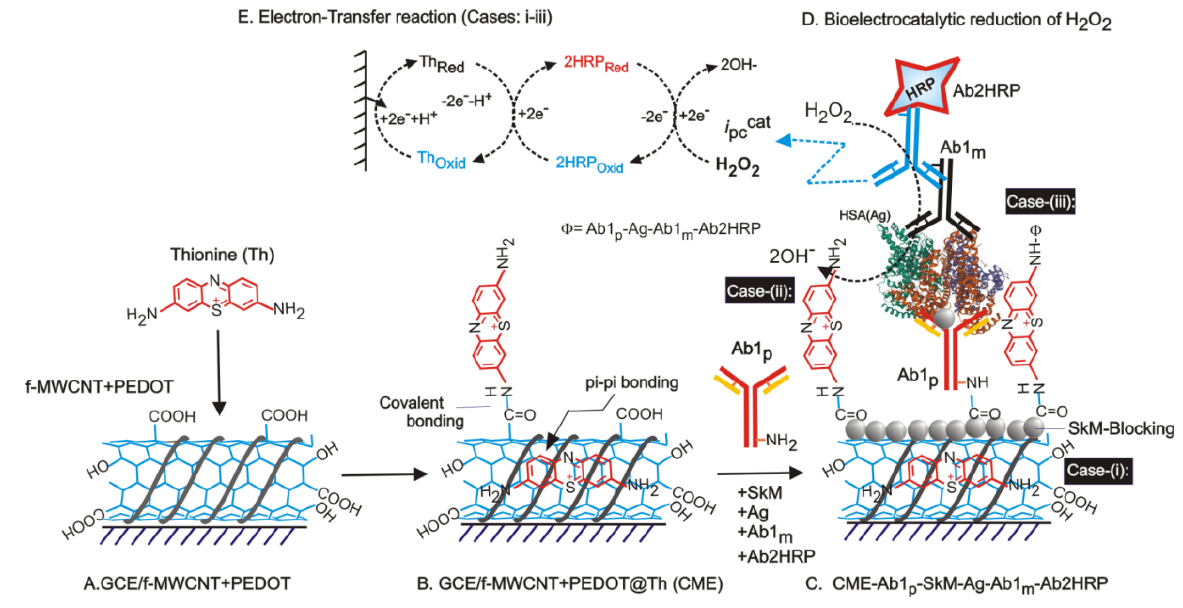
Figure 3. Diagrammatic illustration for preparation of electrochemical biosensor for human serum albumin (HSA) present in urine samples using a sandwich ELISA involving CME-Ab1 p -SkM-Ag(HSA)-Ab1 m -Ab2HRP modified electrodes ( A – C ) and its ( D ) bio-electrocatalytic reduction of H 2 O 2 . The Ab1 p =Polyclonal primary antibody, Ab1 m =Monoclonal primary antibody, SkM =Skim milk power as a blocking agent, Ag = HSA, Ab2HRP = Horseradish peroxide enzyme tagged Ab1 p . Cases-(i–iii) are possible routes for molecular orientations of surface-confined -Th and its interactions with biological systems. Rights and permissions, copyright [102]. Table 7. Disease detection using the electrochemical platforms in various conditions.